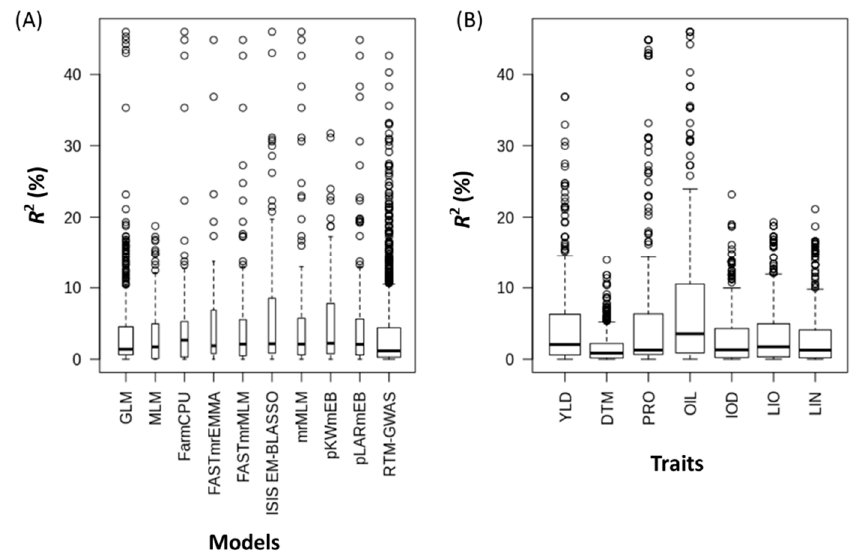
Figure 3. Boxplots of allele e ff ects ( R 2 ) of quntitativ trait loci (QTL) for ten genome-wide association